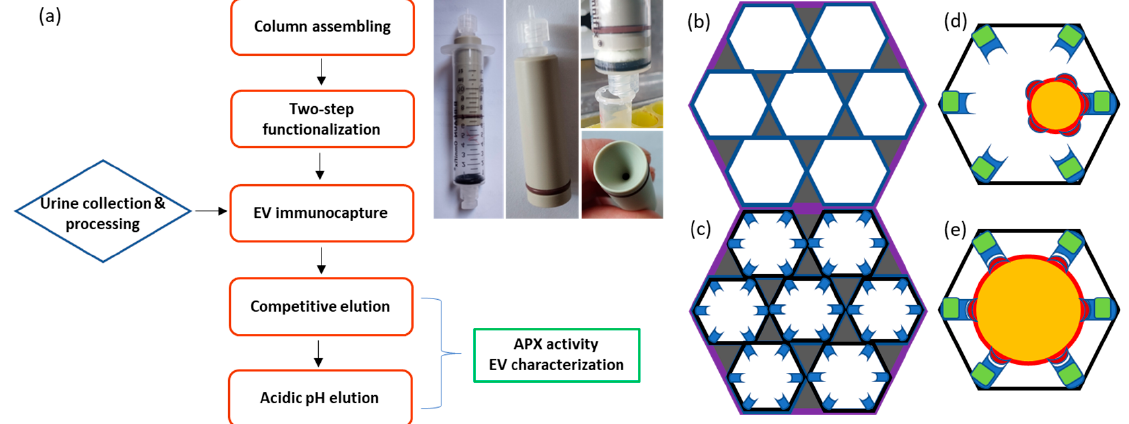
Figure 2. Flowchart of urine EV purification using a monolith filter and its use as chromatographic immunoaffinity matrix . ( a ) The chromatographic column was obtained by inserting the monolith disc into a syringe with hollow piston. Both syringe entrances have an adaptor for plastic tubing that is connected to a peristaltic pump. This helps to control the solution flux through the